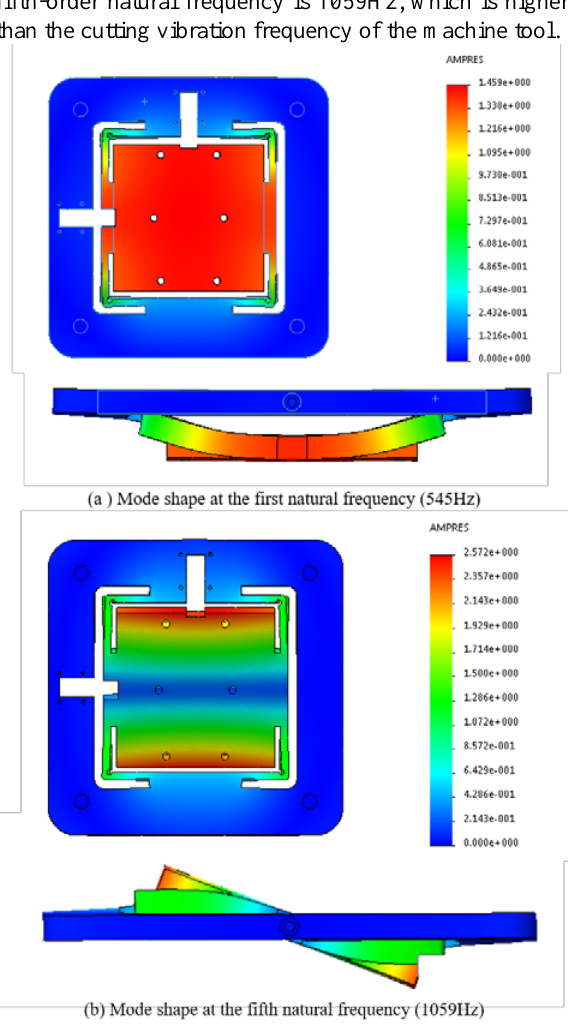
Fig. 5. Modal analysis of the platform.